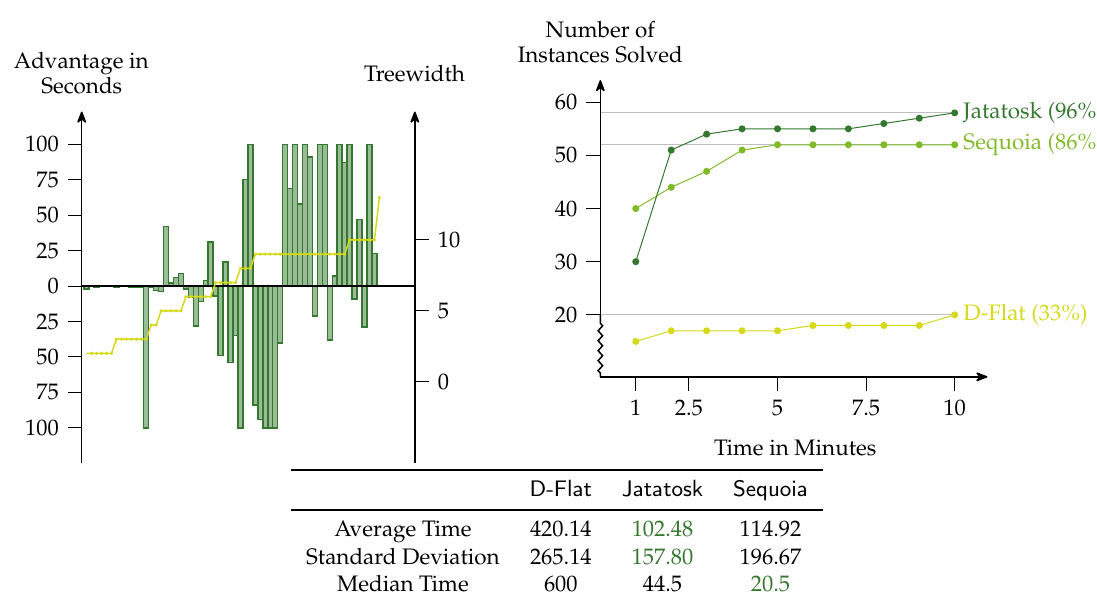
Figure 4. Experiment for the DOMINATING - SET problem.